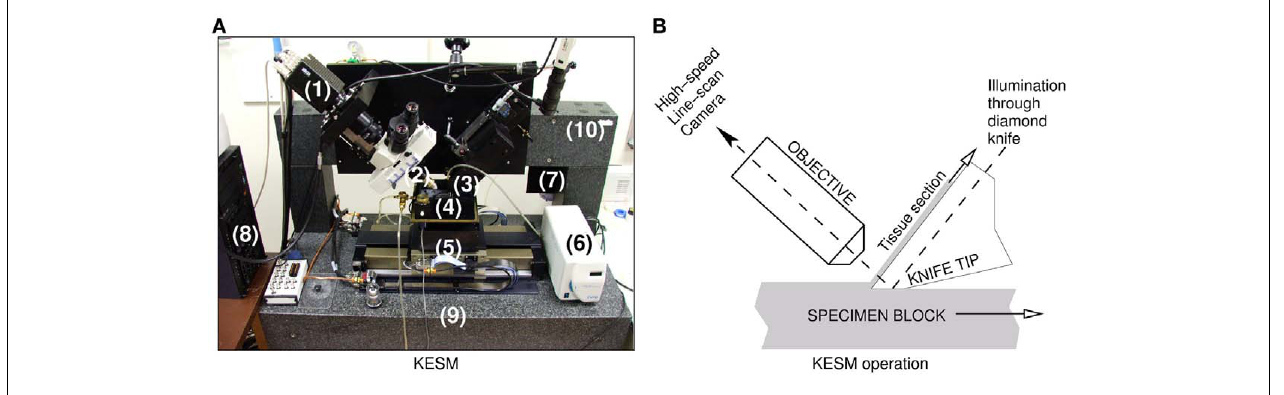
imaging), (5) three-axis precision air-bearing stage, (6) white-light microscope illuminator, (7) water pump (in the back) for the removal of sectioned tissue, (8) PC server for stage control and image acquisition, (9) granite base, and (10) granite bridge. (B) The imaging principle of the KESM is